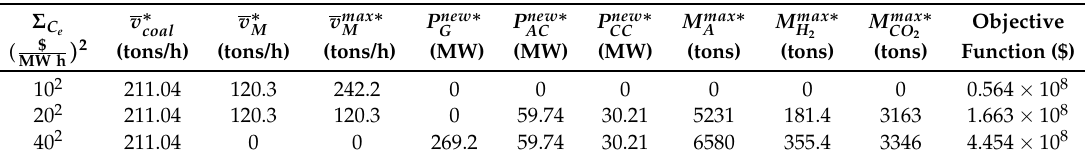
Table 8. Optimal design results as a function of electricity price variance with reduced capital costs of compressors.